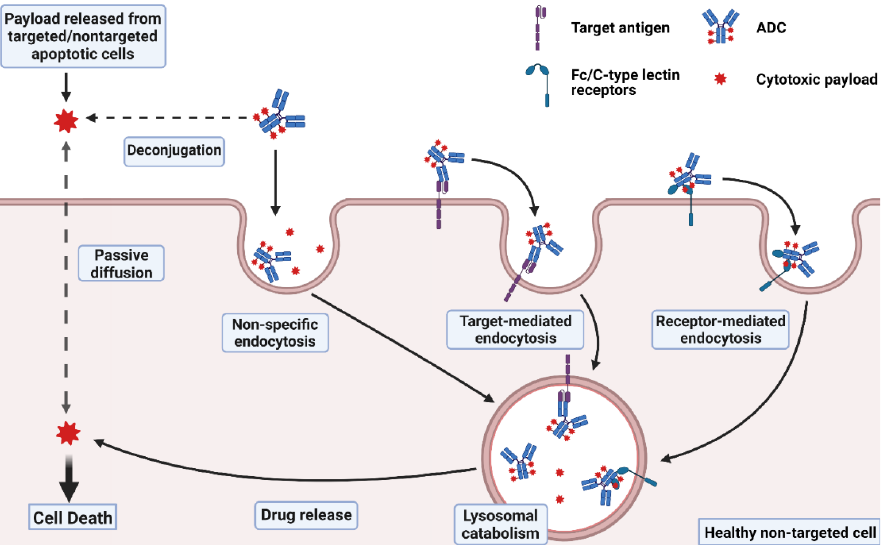
Figure 1. Mechanisms of ADC toxicity. Uptake of intact ADCs into normal cells may occur through non-specific endocytosis, or through internalization upon binding to the target antigen or to Fc/C-type lectin receptors. Payloads released from ADC deconjugation or other targeted/non-targeted apoptotic cells in the extracellular fluid may also enter normal cells via passive diffusion for membrane- permeable payloads or via non-specific endocytosis for membrane-impermeable linker-payload adducts. Created with